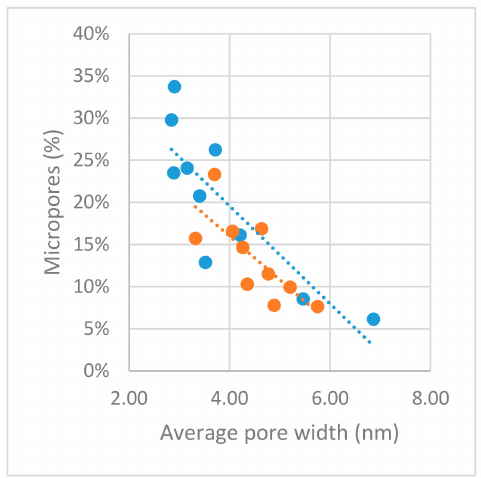
Figure 19. Relationship between average pore width vs the percentage of micropores.